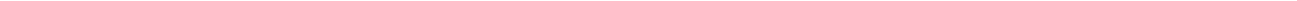
Fig. 1 The human cochlear prosensory domain. a Three stages of human cochlear development (W8 (E1202), W10 (E1201), and W12 (E1210)). Shown are overview modiolar cyosections, immunolabeled with antibodies to p27Kip1. F-actin was labeled with phalloidin and cell nuclei were stained with DAPI. Scale bar = 1 mm. b Cochlea at W8 (E1202) of development, immunostained for p27Kip1 and Ki67. Right and left cochleae from the same fetus are shown. The prosensory domain (PSD) and the spiral ganglion (SG) are indicated. Pink dashed lines indicate the lack of KI67 positivity in the PSD in apical and middle turn. Scale bar = 100 μ m. c Characterization of the W8.4 (E1251) PSD by immunostaining for SOX2 and p27Kip1. Scale bar = 100 μ m. Apical and basal turns are shown as indicated. d Characterization of W12 (E1210 top and E1203 bottom) PSDs with immunostaining for SOX2 and p27Kip1. Upper panel shows the basal turn, lower panel shows the localization of the two markers in the base, middle, and apex. Scale bar = 50 μ m. e Schematic comparison of the timing of cell cycle exit between mouse and human. f Immunostaining for SOX2, LGR5, and MYO7A of human fetal cochlear PSDs at W8 (E1202), W10 (E1201), and W12 (E1210) of development. Basal turns are shown for all-time points. Scale bar = 100 μ m. g In situ hybridization (brown dots) with a LGR5-speci fi c RNAscope probe at W9.2 of development (E1276) Basal, middle, and apical turns are shown. Sections are counterstained with haematoxylin (blue) to visualize tissue morphology. Scale bar = 50 μ m. h Immunostaining for SOX2 and MYO7A of cochlear PSDs at W11 (E1195) and W12 (E1203). The basal, middle, and apical turns are shown. Scale bar = 50 μ m. i Schematic comparison of the timing of hair cell differentiation between mouse and human. j Immunostaining of the entire cochlear duct for EPCAM (red) and p27Kip1 (green) at W10. Scale bar = 100 μ